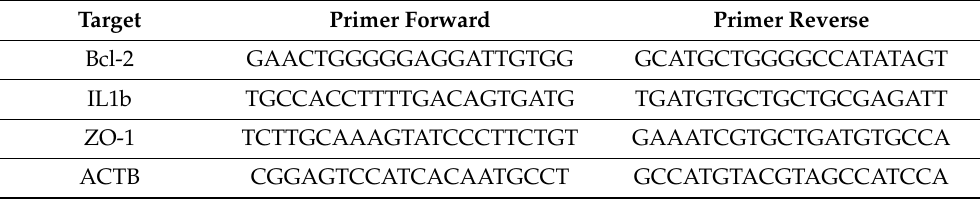
Table 1. Primer sequences used for RT-PCR experiments. Target Primer